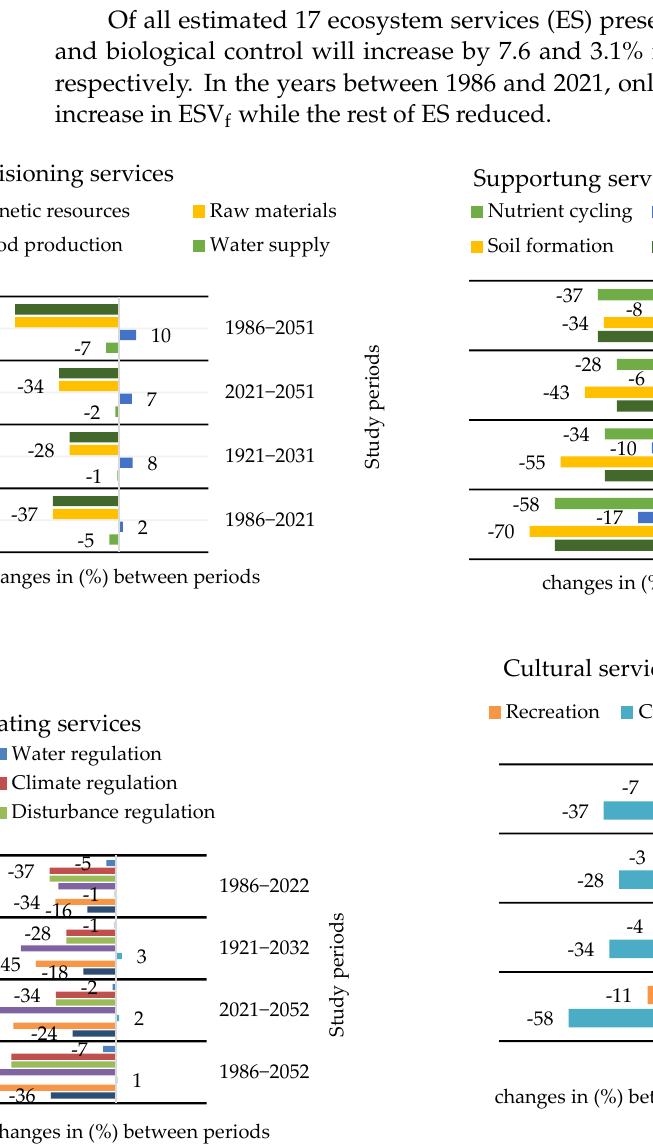
Figure 4. Individual ecosystem service (ESVf) changes in percent (%) between the study periods.